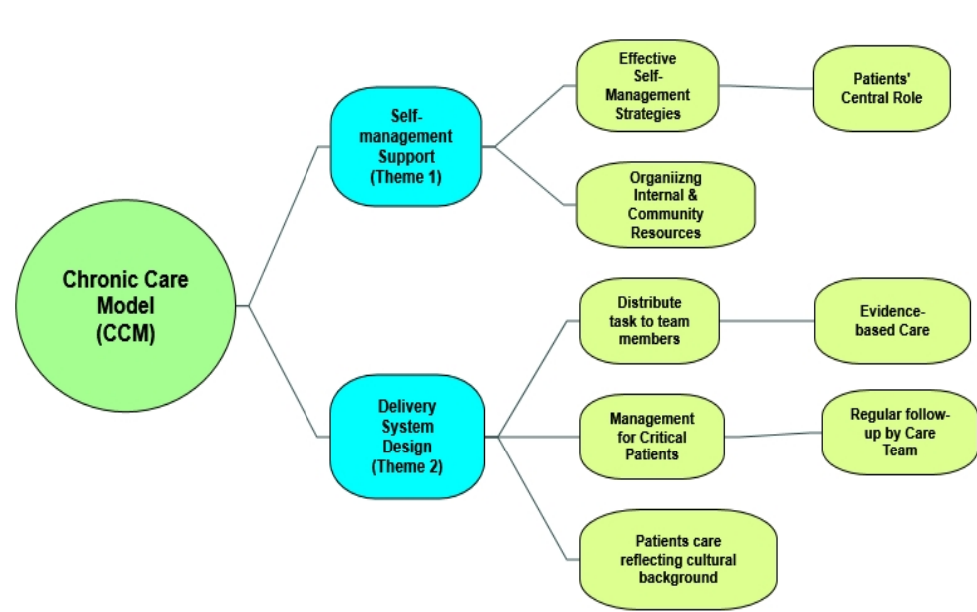
Figure 2. Subthemes of the two main themes of the chronic care model at the practice level.